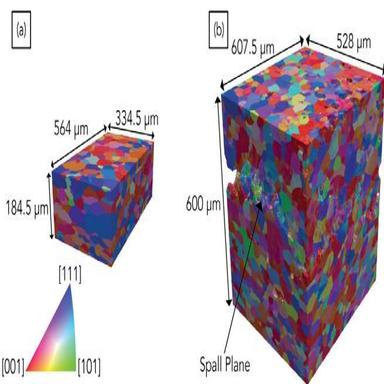
(a) Unshocked tantalum dataset (b) Shock-loaded tantalum dataset, where colors are inverse pole figure (IPF) colors using the loading direction (normal to the rolling direction) as the reference () direction.